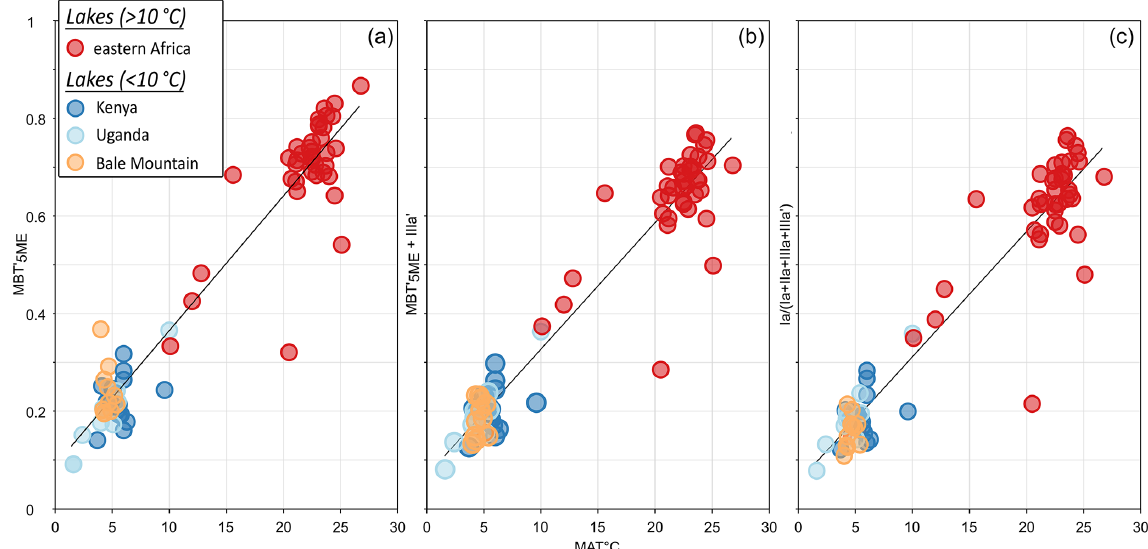
+ IIIa (cid:48) ( r 2 = 0 . 93; RMSE of 2.38); ( r 2 = 0 . 92; RMSE of 2.41); (b) MBT (cid:48) 5ME 5ME